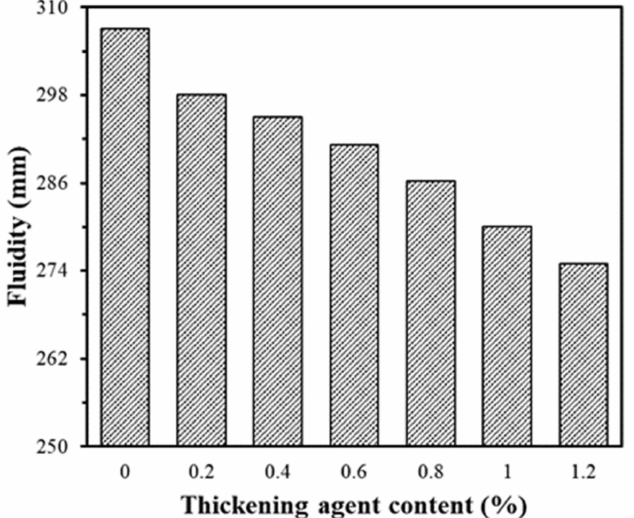
Figure 4. Effect of thickening agent on the fluidity of FCPB